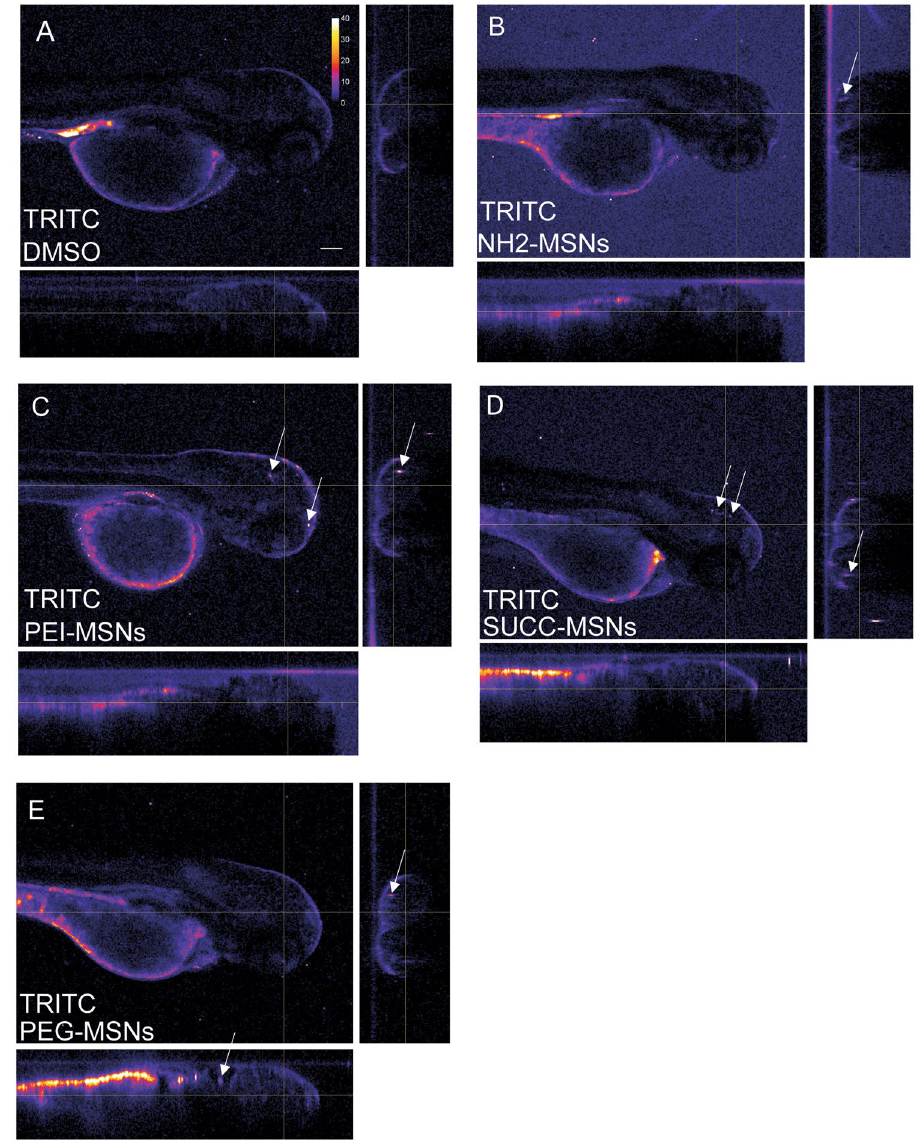
Figure 6. Surface functionalization affects uptake of MSNs. The uptake of the nanoparticles from the aquaeous medium into the embryo was analyzed by mounting anesthesized living embryos into agarose and imaged using confocal microscopy (Leica SP5 Matrix). A transgenic strain (kdrl:EGFP) expressing a GFP labeled vasculature were used. 24hpf embryos were incubated for 48 h with the highest tolerated dose of the different nanoparticles e.g 100 μ g/ml NH2-, SUCC- and PEG-MSNs, and 10 μ g/ml of PEI-MSNs. DMSO treated embryos were used as controls and show background fluorescence ( A ). Ortohogonal views of the 3D confocal data sets are shown to visualize fluorescence deep inside the embryo. Panels are pseudocolored for clearer visualization of nanoparticle fluorescence in the brain. Calibration bar in panel 6A indicates relation between colour and intensity values. White arrows mark nanoparticle clusters inside the embryo brains. Scale bar is 100 µ